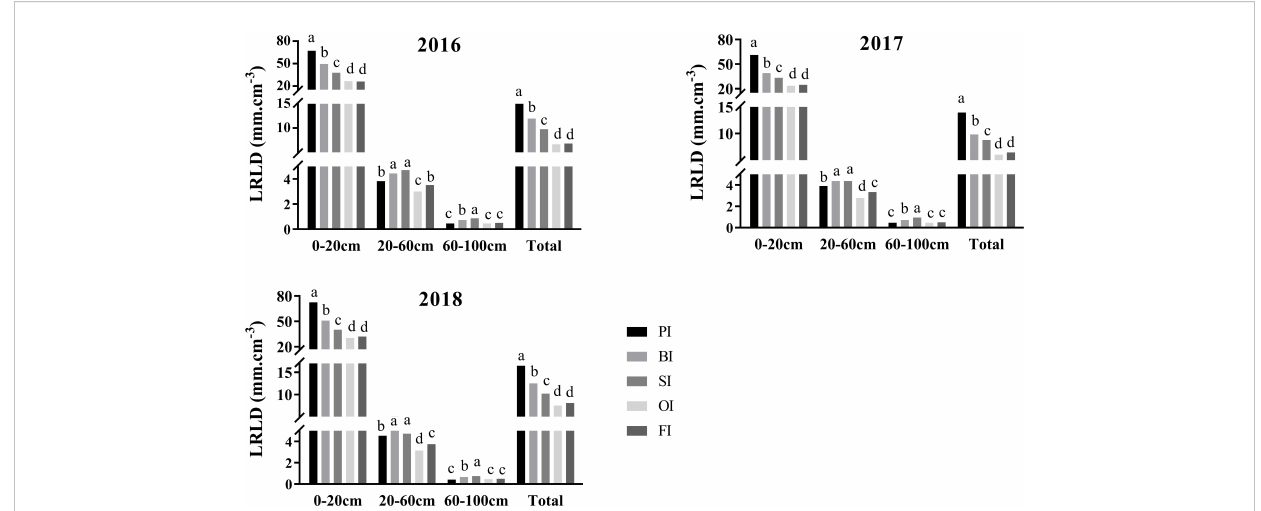
FIGURE 2 Live root length density (LRLD) distribution at silking in different soil layers. PI and BI represent drip irrigation under plastic fi lm mulch and biodegradable fi lm mulch, respectively; SI, drip irrigation incorporating straw returning; OI, drip irrigation with the tape buried at a shallow soil depth; FI, furrow irrigation. Different lowercase letters indicate signi fi cant differences at P < 0.05.